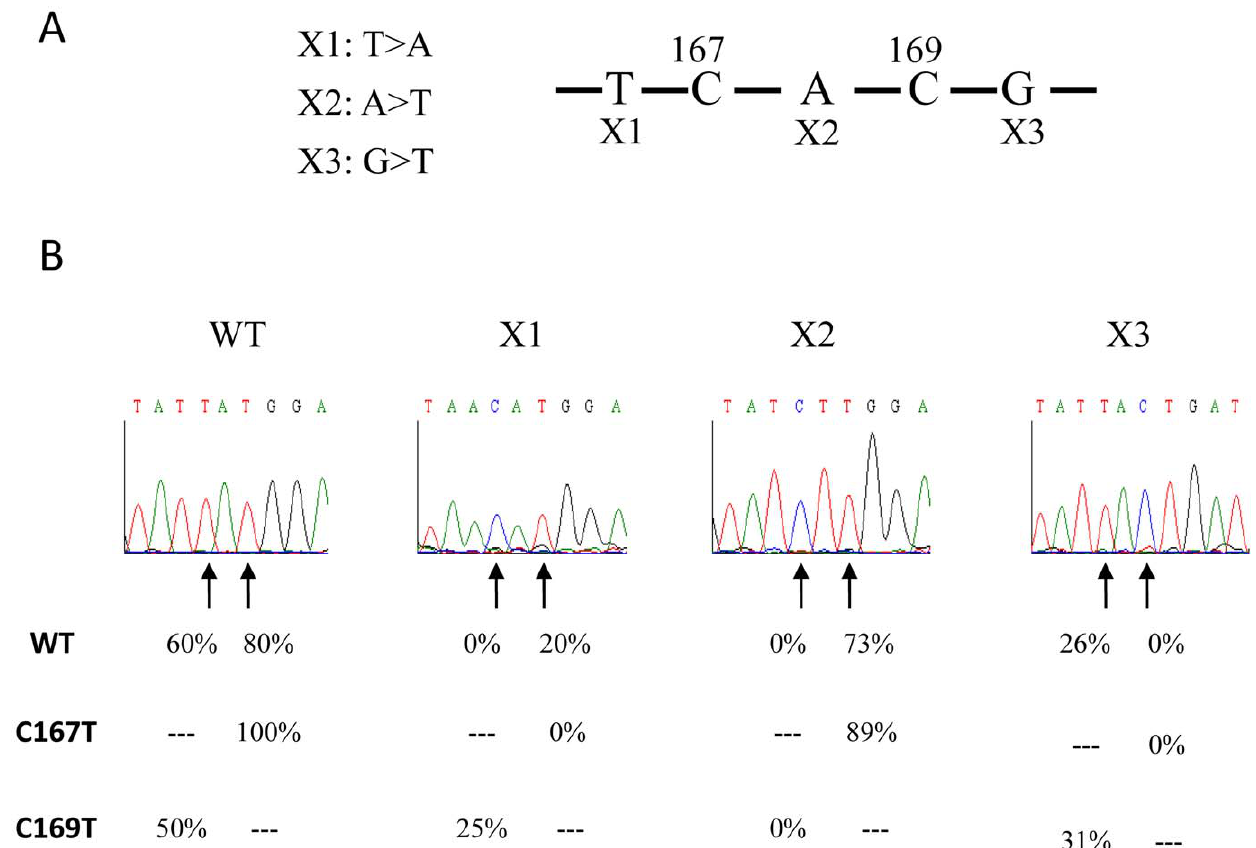
Figure 4. Editing of mutants of overlapping C167 and C169 sites. (A) Sequence encompassing sites C167 and C169. 6 1 and 6 2 represent the 2 1 and the + 1 mutations of the site C167 respectively. 6 2 is also the 2 1 mutant of site C169. 6 3 represents the + 1 mutation of the site C169. (B) Chromatopherograms of the sequences surrounding the sites C167 and C169 from different constructs. Arrows indicate the C167 (left) and C169 (right) editing sites. The editing efficiency in wild type and mutant transcripts is indicated below the chromatopherogram. C167T and C169T indicate the presence of a residue T at the place of the editing target C167 and C169 respectively. At least 16 independent RT-PCR clones were sequenced for each construct.